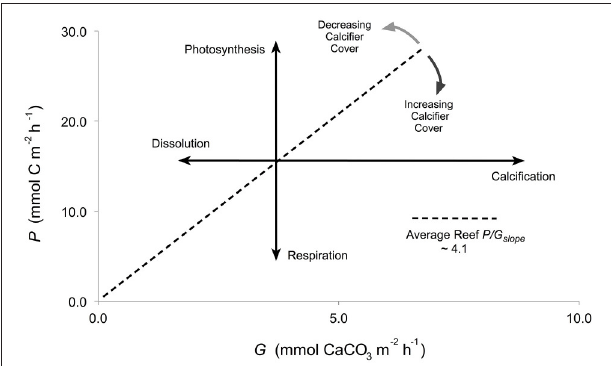
FIGURE 1 | Conceptual diagram representing reef net production (mmol C m − 2 h − 1 ) as a function of net calcification (mmol CaCO 3 m − 2 h − 1 ) with an average P/G slope of 4.1 (Shaw et al., 2015). Bold arrows represent the slope for the individual processes of photosynthesis, respiration, calcification, and dissolution. Light gray arrows represent the theoretical shift to a P/G ratio > 4.1 for a reef with > 20% cover of calcifiers. Dark gray arrows represent a shift to a P/G ratio < 4.1 for a reef with < 20% cover of